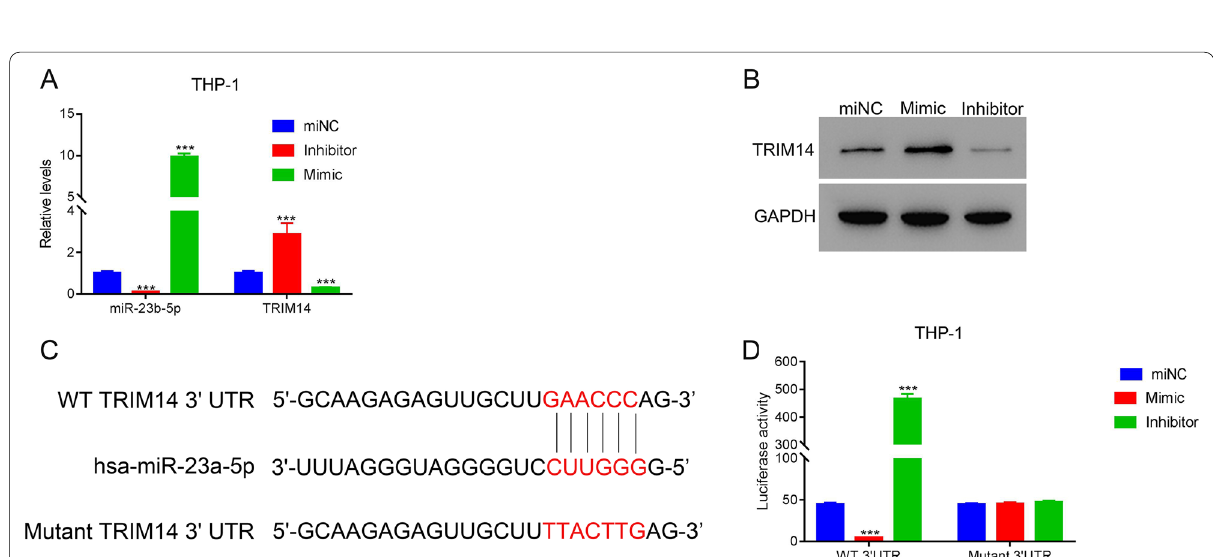
Fig. 5 miR-23a-5p suppressed the expression of TRIM14 through binding on its 3’UTR in AML cells. A The level of miR-23b-5p and TRIM14 in THP-1 cells after the transfection of miR-23b-5p miNC, inhibitor and mimic. B The protein of TRIM14 was in THP-1 cells after the transfection of miR-23b-5p miNC, inhibitor and mimic. C The potential binding site of miR-23a-5p in the 3’UTR region of TRIM14. D The luciferase activity THP-1 cells after co-transfected with wildtype and mutant TRIM14 vectors as well as miR-23a-5p miNC, mimic and inhibitor. *** p <